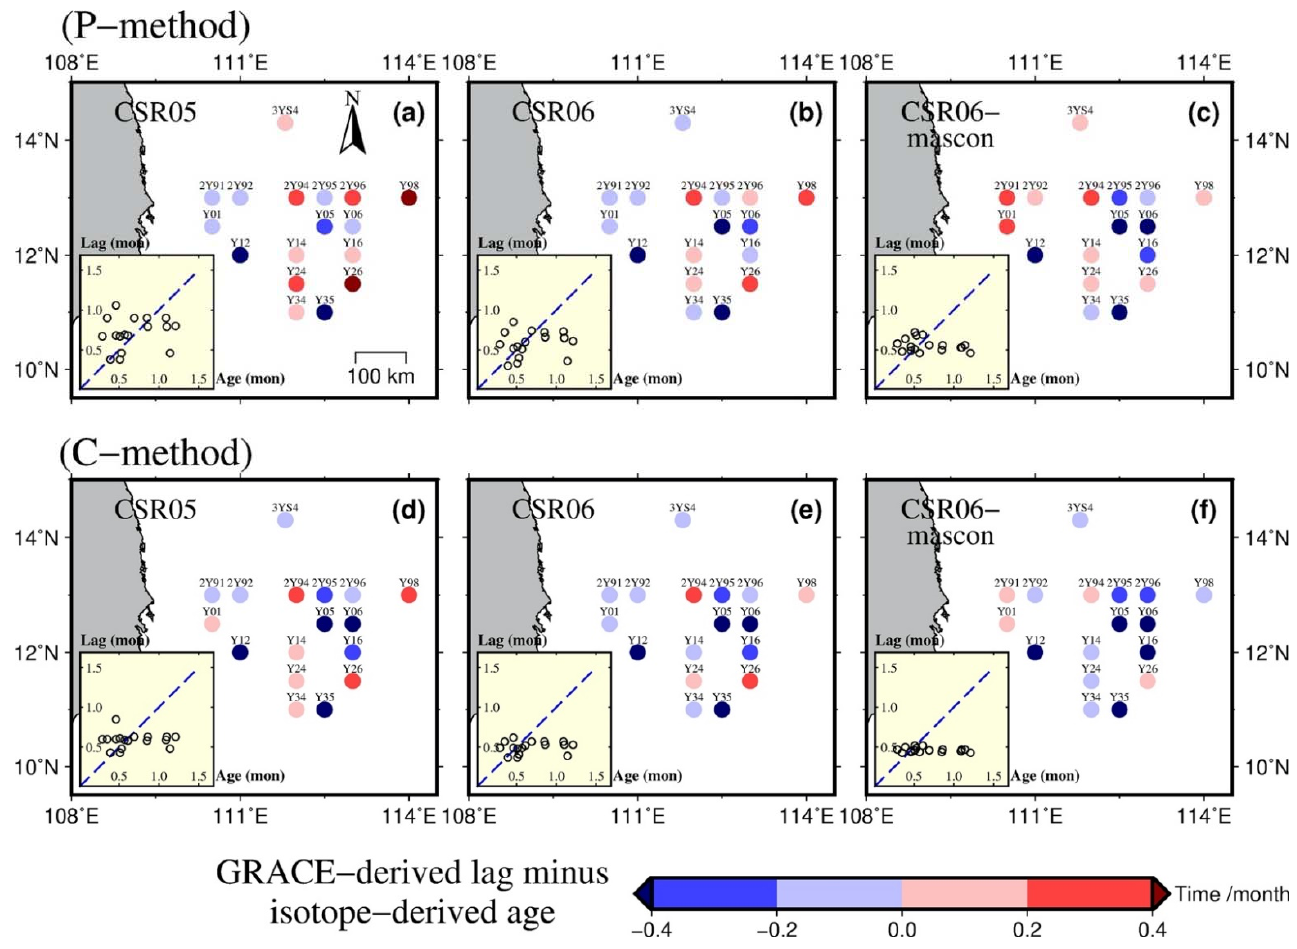
Figure 8. Difference between GRACE ‐ derived time lag and isotope ‐ derived age for 17 selected isotope samplings. Note that the GRACE ‐ derived time lag was calculated from CSR05, CSR06 and CSR06 ‐ mascon using the P ‐ method ( a – c ) and the C ‐ method ( d – f ), respectively. The subgraphs (bottom left) plot the scatterings of the corresponding time lag and age from the different versions of GRACE data, derived using the P ‐ method and the C ‐ method. Table 3. The mean and standard deviation of the isotope ‐ derived age, the GRACE ‐ derived lag, and their difference using the P ‐ method and the C ‐ method.